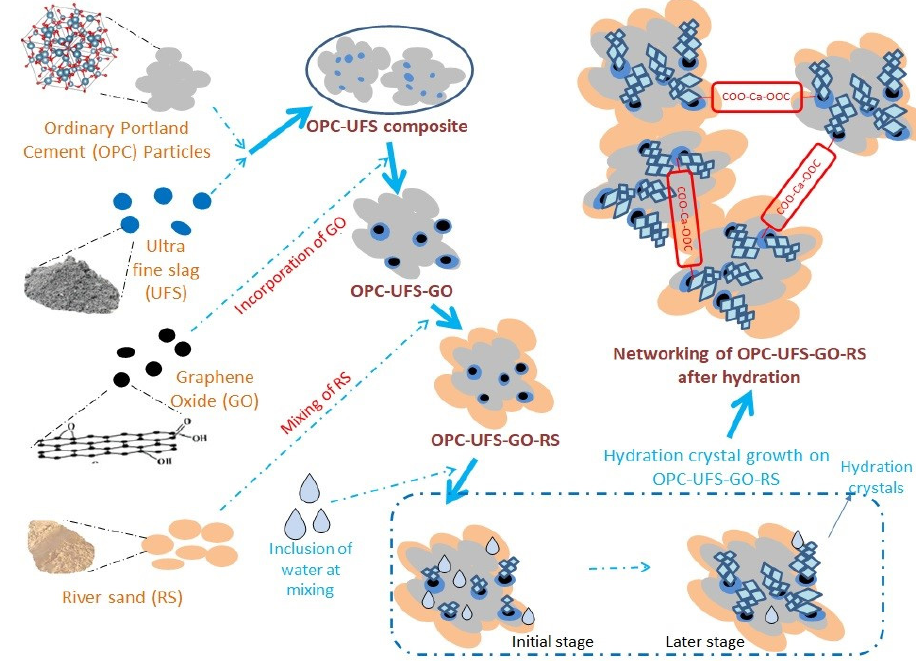
Figure 3. Schematic diagram representing hydration of OPC-UFS-GO-RS.